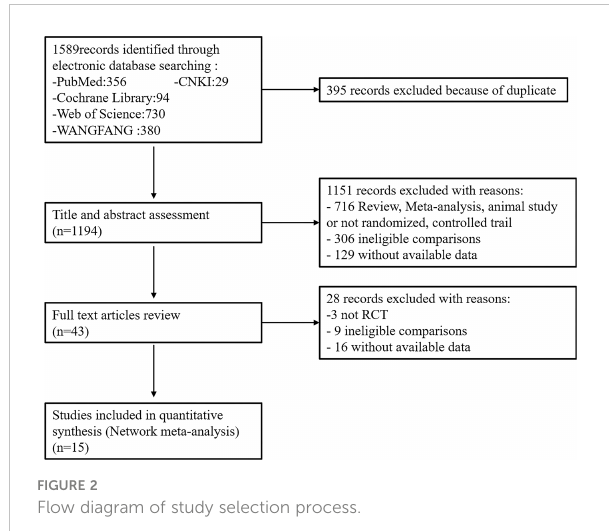
FIGURE 2 Flow diagram of study selection